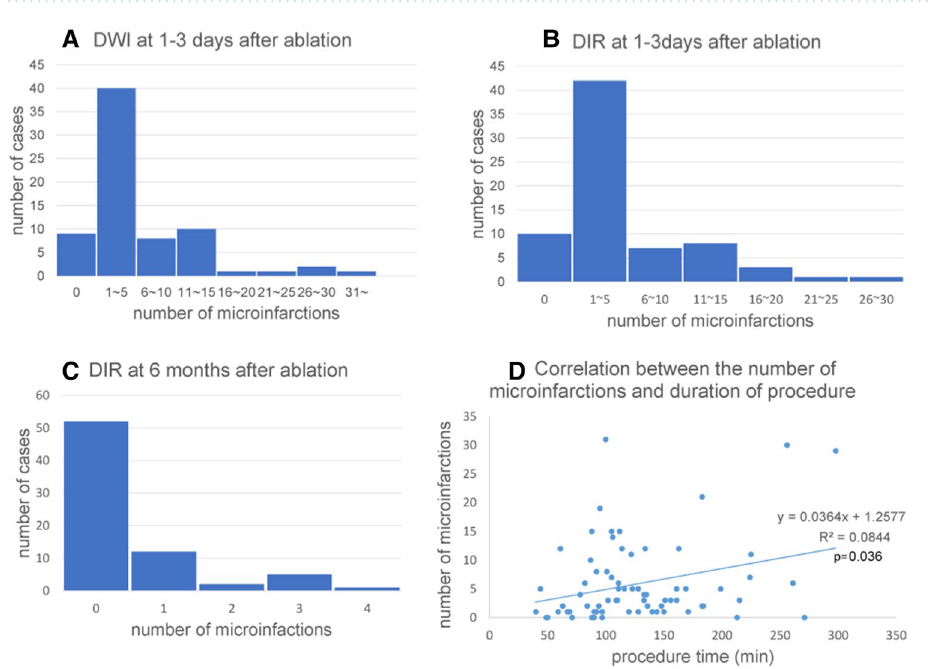
Figure 3. Number of DWI ( A ) and DIR ( B ) positive lesions per case at baseline, and DIR positive lesions per case at 6 months after ablation ( C ). At baseline, one to five lesions were most frequent, however, most lesions disappear on follow-up DIR images. A mild positive correlation was observed between the number of microinfarctions and duration of ablation procedure ( p = 0.036) ( D